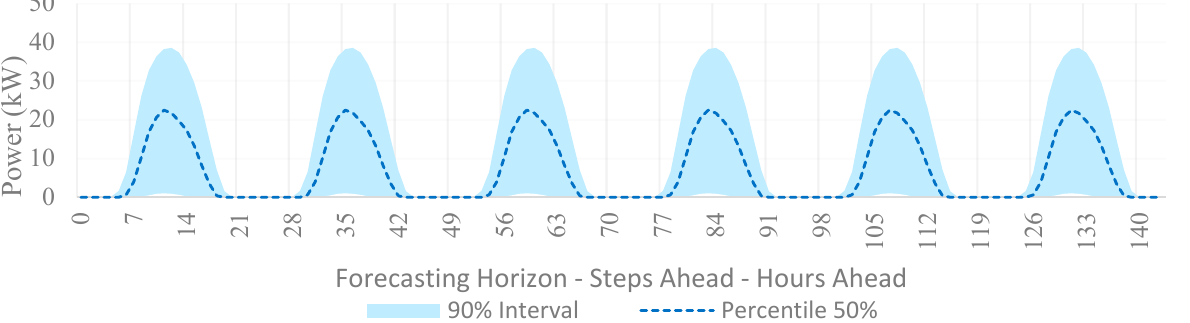
Figure 4. The dashed dark blue line represents the mean, and the light blue area represents the 90% interval probability distribution of power for the CH-PeEn benchmark for the target PV system for six consecutive days.